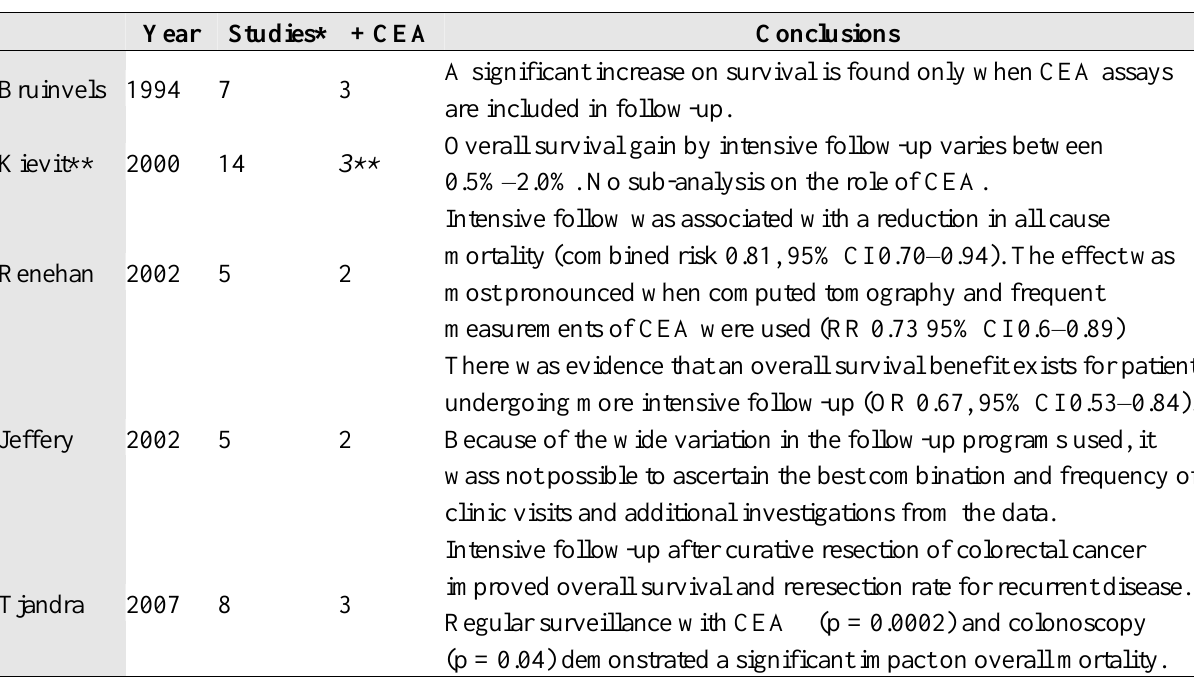
Table 3. Summary of meta-analyses on follow-up for colorectal cancer and inclusion of trials comparing different CEA